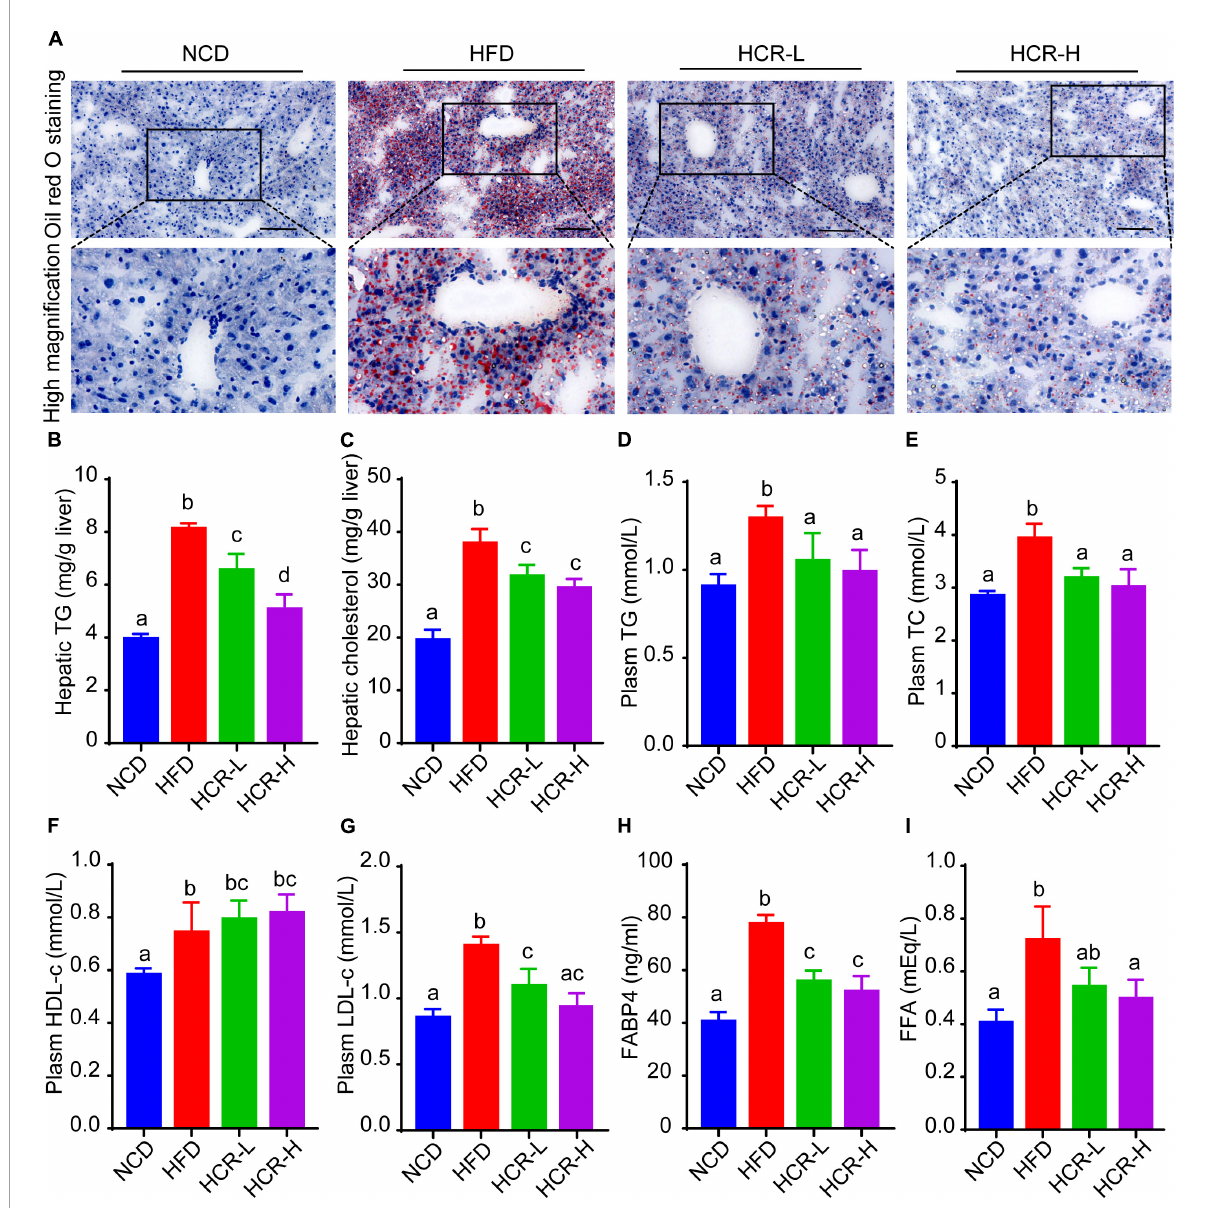
FIGURE2 Cori alleviated hepatic and plasma lipid concentrations in HFD-fed mice. (A) Oil Red O staining of liver in indicated groups. Bar = 50 µ m. (B) TG and (C) TC levels in liver were detected. (D) Plasm TG, (E) TC, (F) HDL-c, (G) LDH-c were tested. (H) FABP4 in plasma was measured. (I) FFA in plasma was examined. Values were means ± SD, and for statistical analysis, one-way ANOVA were performed between indicated